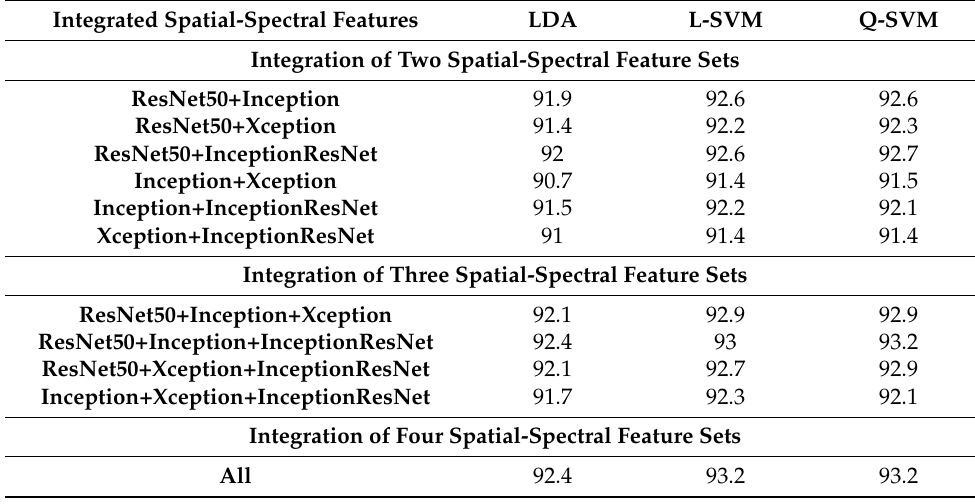
Table 5. The accuracy (%) achieved for the three classifiers trained with integrated spatial-spectral features using DWT.